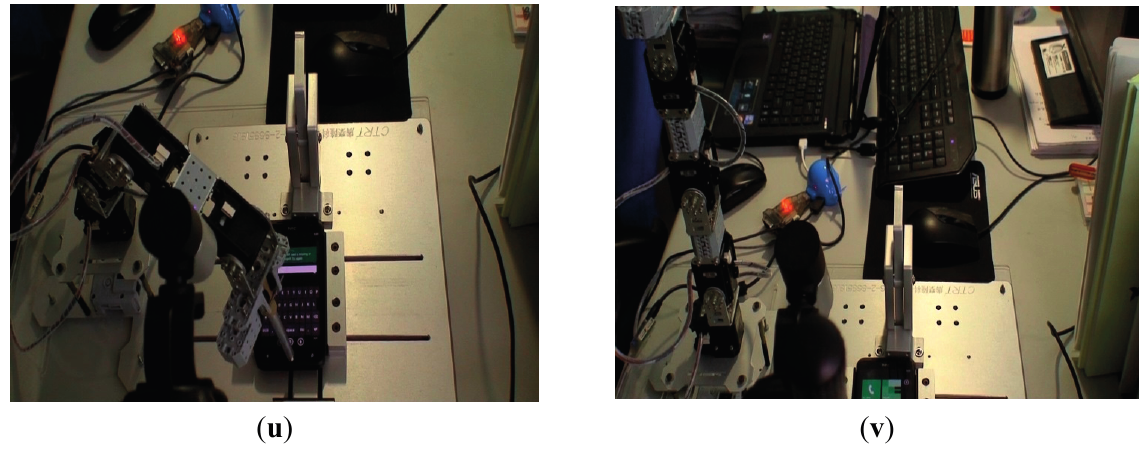
Figure 28. Command: Send a message to “Tom”. ( a ) Snap words from command panel (PC screen); ( b ) Captured words recognized by the processor; ( c ) Move robot arm to